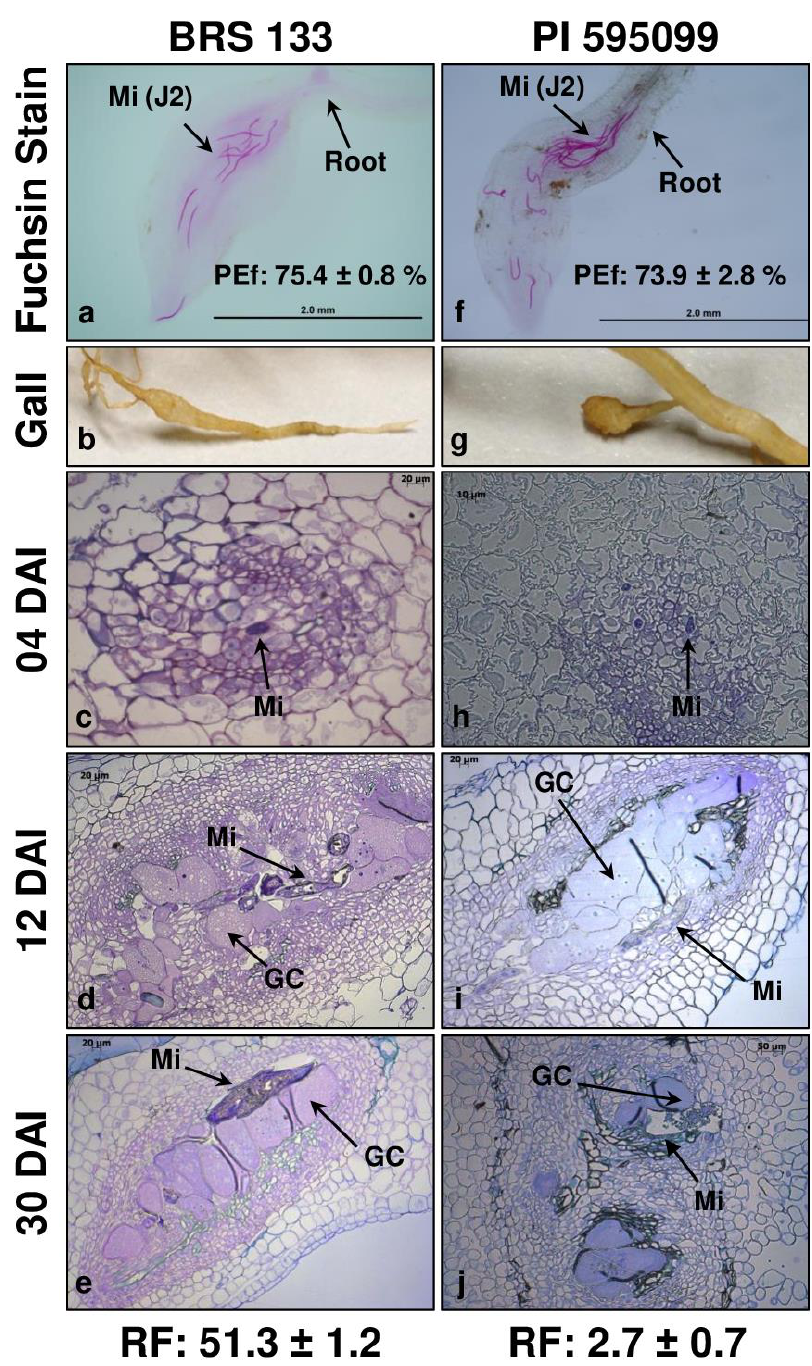
Figure 1. Morphological analysis showing the interaction of soybean roots from two contrasting soybean genotypes: BRS 133 ( a – e ) and PI 595099 ( f – j ), inoculated with the nematode M. incognita . In ( a , f ), root tips inoculated with the nematode are presented 4 days after inoculation (DAI). The penetration coefficient (PEf) is similar for both genotypes. In ( b , g ), the observed differences in morphology from the galls are shown (BRS 133 is elongated while PI 595099 is ovoid). Comparing the galls or root tips isolated from BRS 133 ( c – e ) and PI 595099 ( h – j ) evidence that the time course of M. incognita infection in both genotypes is similar. Only a slight delay in the development of galls and a smaller cytoplasmic volume in the giant cells were observed in PI 595099 samples. GC —giant cell; J2 —juvenile phase 2 of M. incognita development; Mi — M. incognita ; PEf —penetration efficiency; RF —reproduction